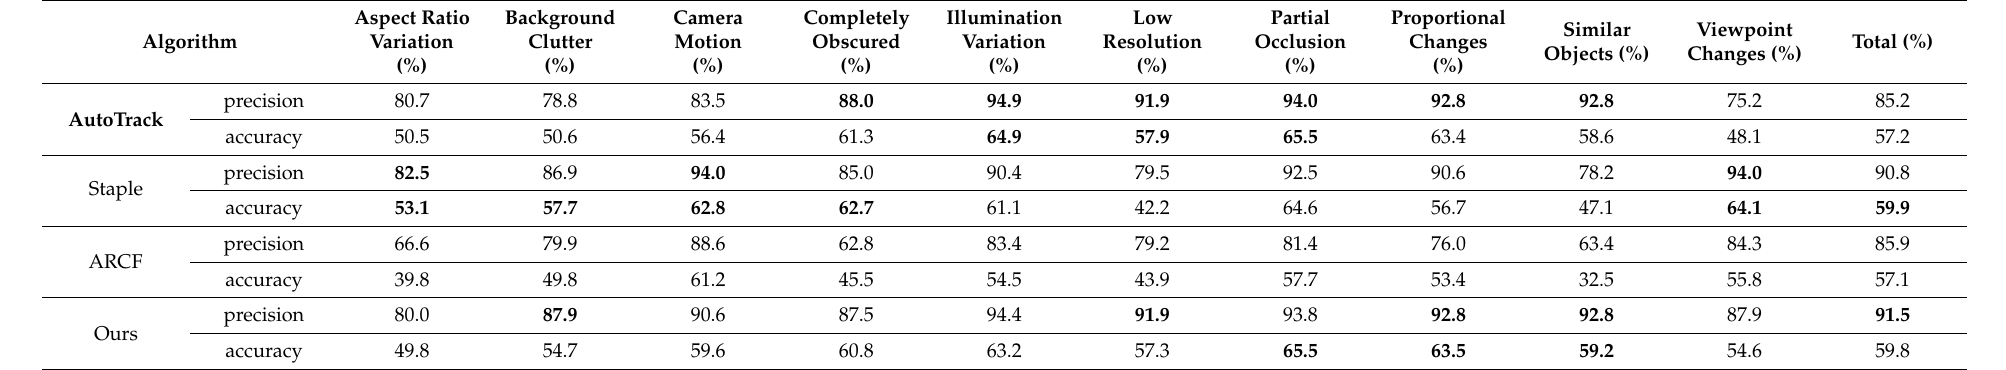
Table 4. Comparison of the precision and accuracy under different correlation filtering